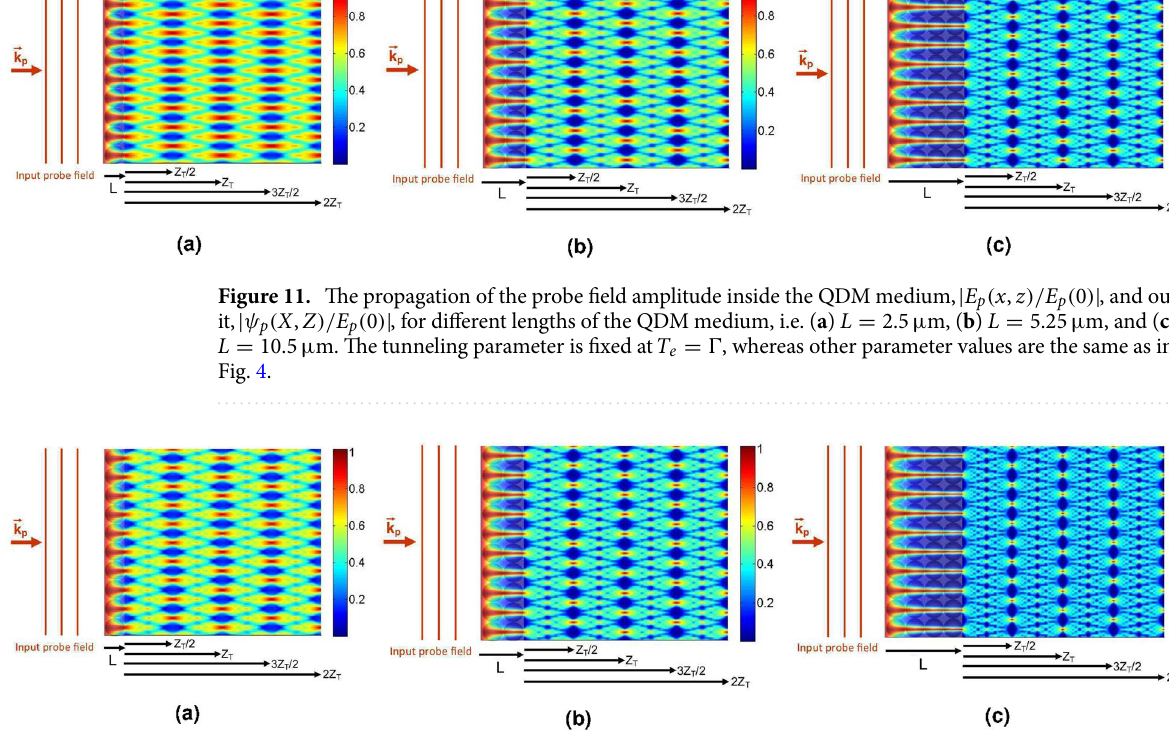
Figure 12. The propagation of the probe field amplitude inside the QDM medium, | E p ( x , z )/ E p ( 0 ) | , and outside it, | ψ p ( X , Z )/ E p ( 0 ) | , for T e = 0.5 Ŵ and different lengths of the QDM medium, i.e. ( a ) L = 1 µ m, ( b ) L = 2 µ m, and ( c ) L = 4.25 µ m. Other used parameters are the same as in Fig.